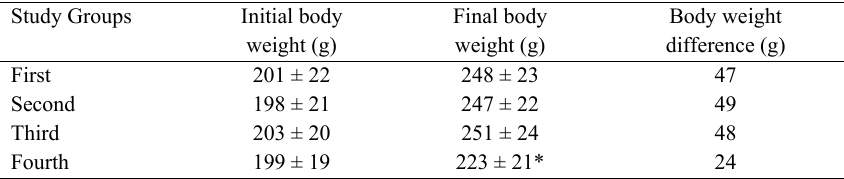
Table 1. Body weight following intraperitoneal injection of NSPs (20, 80, 320 mg/kg) in rats. Study Groups